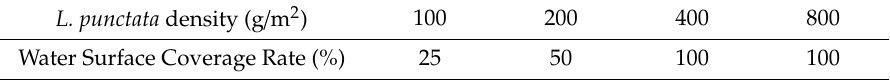
Figure 1. Fresh weight growth rates of L. punctata after 15 days of culture. ( a ) L. punctata cultured alone, and ( b ) L. punctata co-cultured with M. aeruginosa . Values are means ± SE from three biological Table 1. The L. punctata water surface coverage rate of each inoculation density.